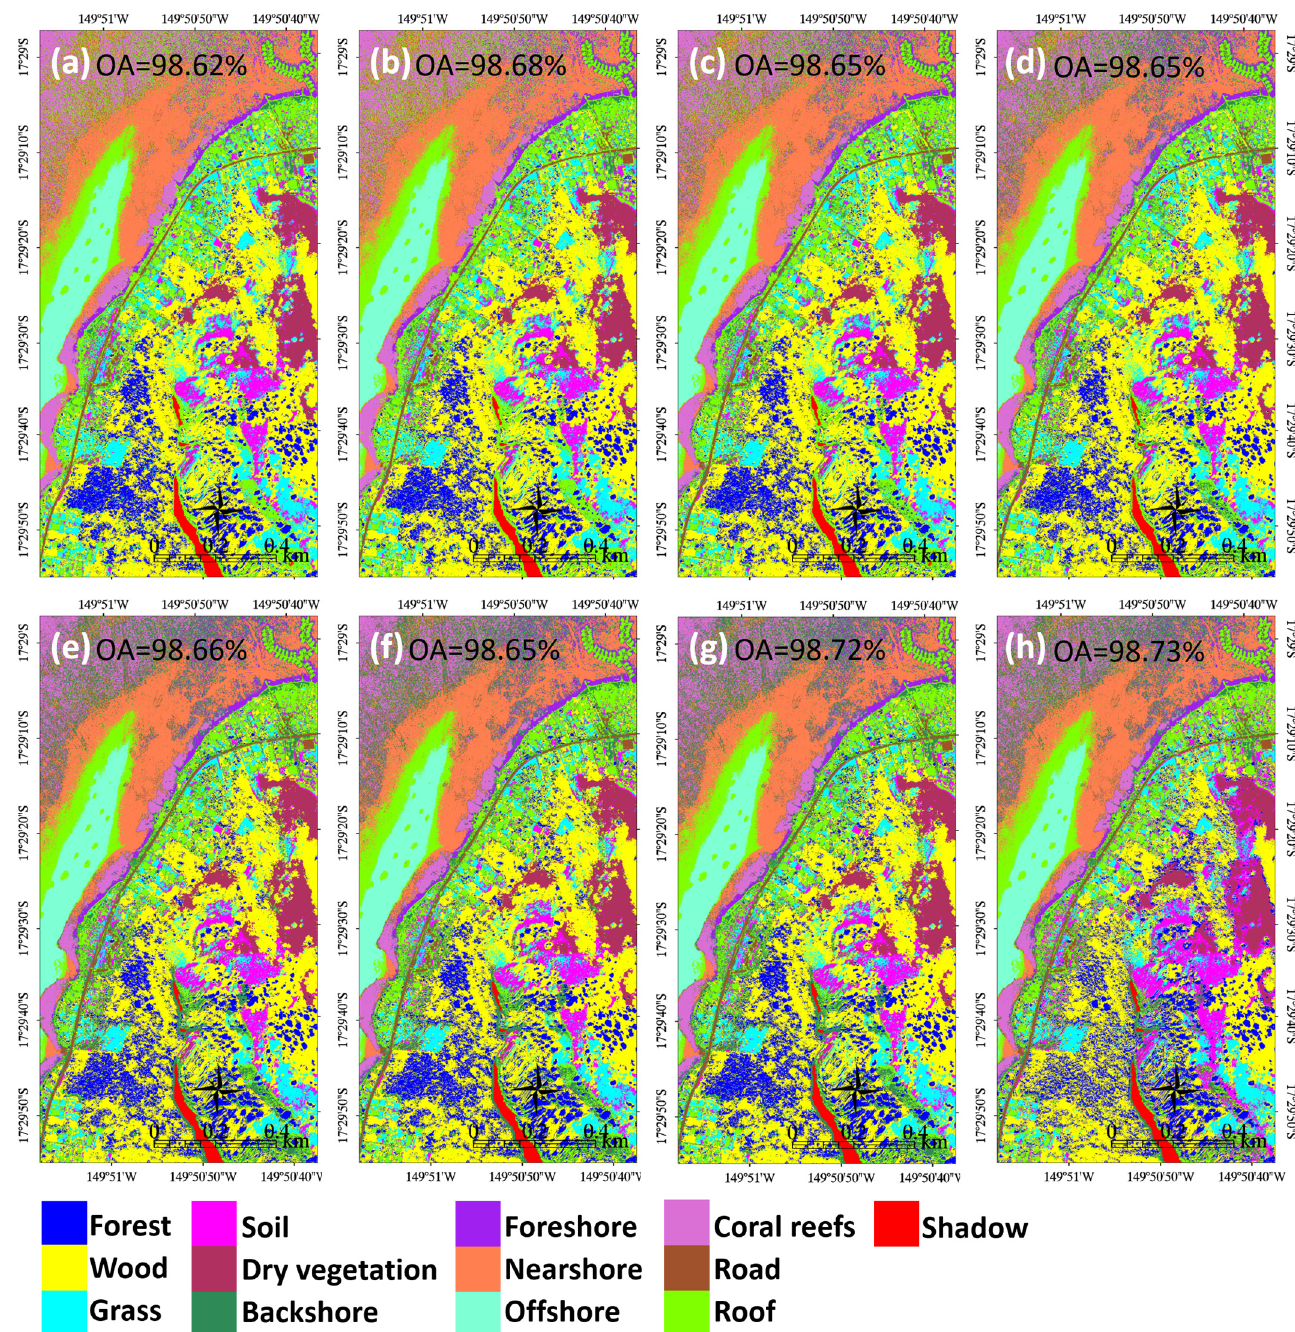
Figure 6. Maximum likelihood classification maps of the land-sea coral reefscape using WorldView-3 optical dataset with: ( a ) Mid-InfraRed1 (MIR1); ( b ) MIR2; ( c ) MIR3; ( d ) MIR4; ( e ) MIR5; ( f ) MIR6; ( g ) MIR7; ( h ) MIR8.